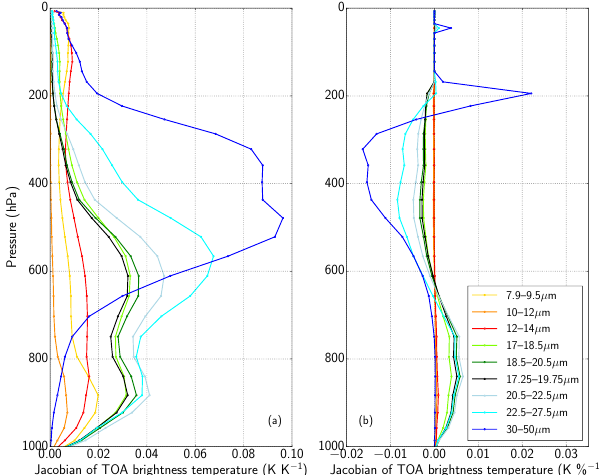
Figure 14. (a) Temperature and (b) humidity Jacobians for the TOA brightness temperature for 11 April atmospheric profile. For humid- ity, variations are in % of the specific humidity.